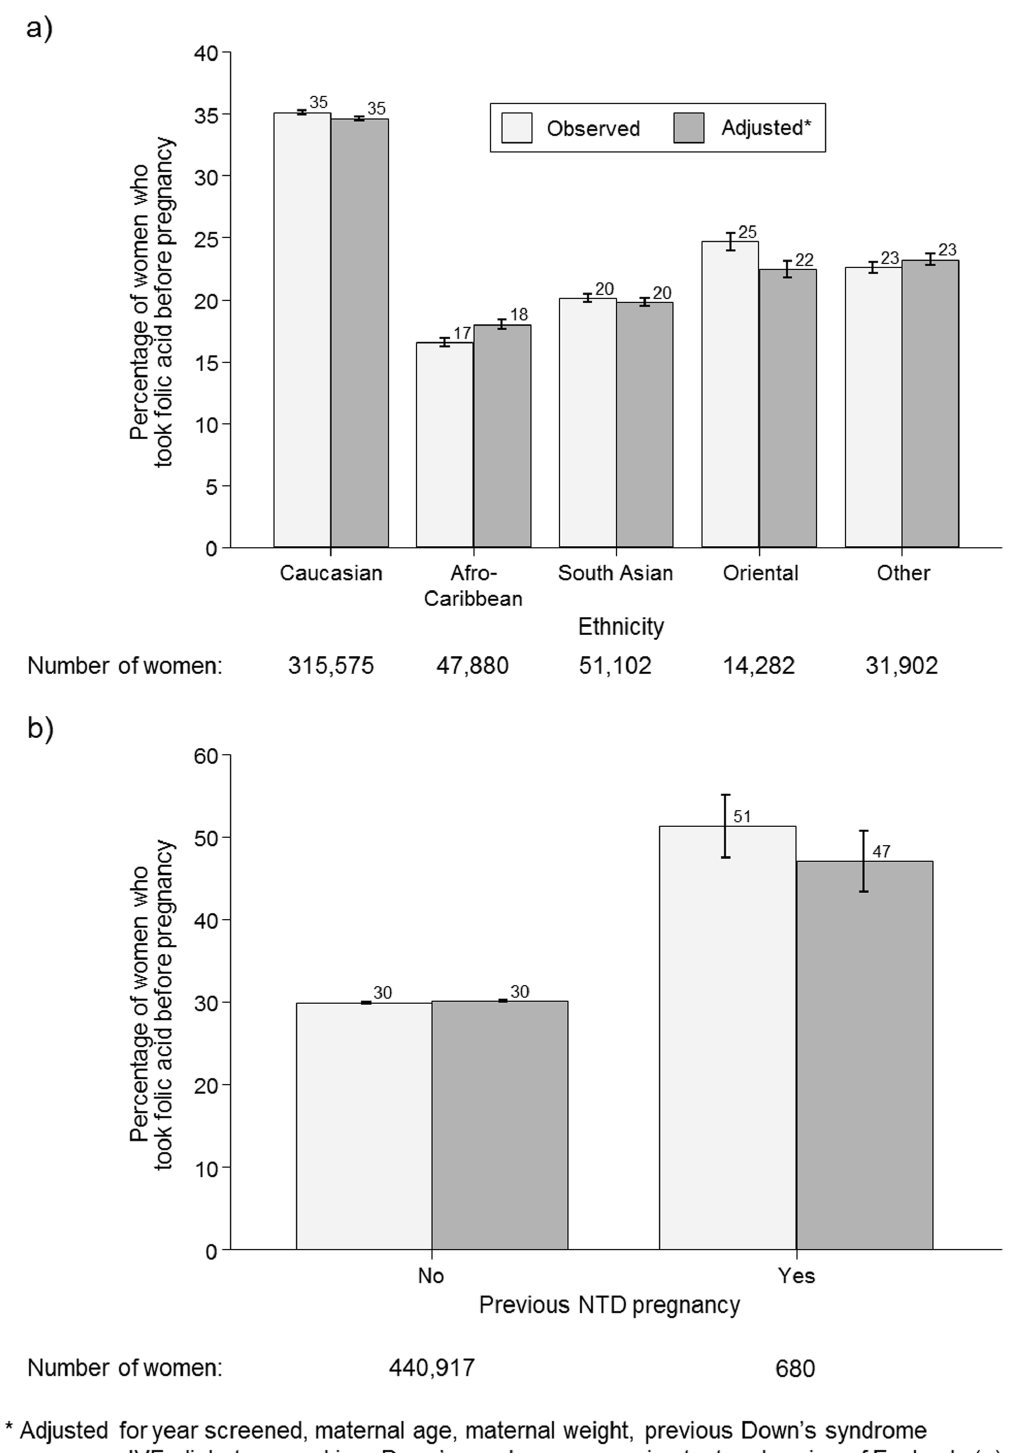
Figure 4. Observed and adjusted* percentage of women taking folic acid supplements before pregnancy according to ethnicity (a) and previous neural tube defect (NTD) pregnancy (b). doi:10.1371/journal.pone.0089354.g004 The prevention of neural tube defects is a global problem. Our pregnancy folic acid supplementation alone. Improved education results show that public health policy cannot rely on pre- in communities with particularly low rates of pre-pregnancy folic